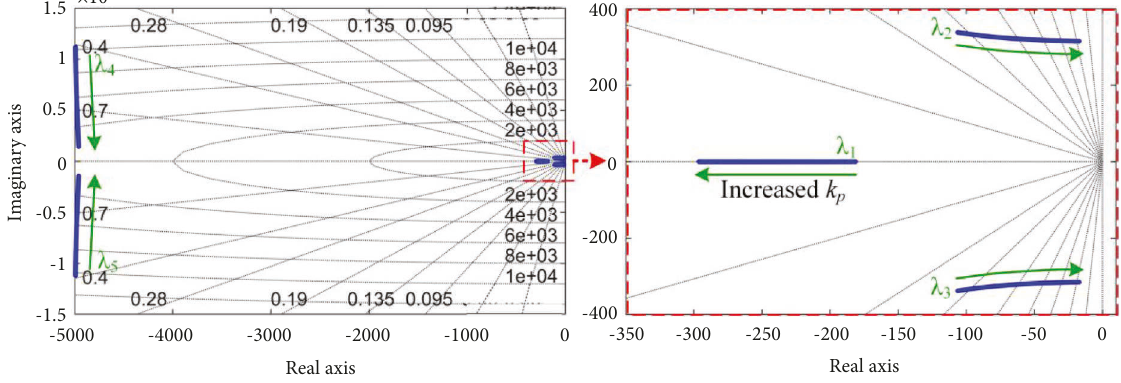
Figure 11: Generalized root locus diagram with a variation of k